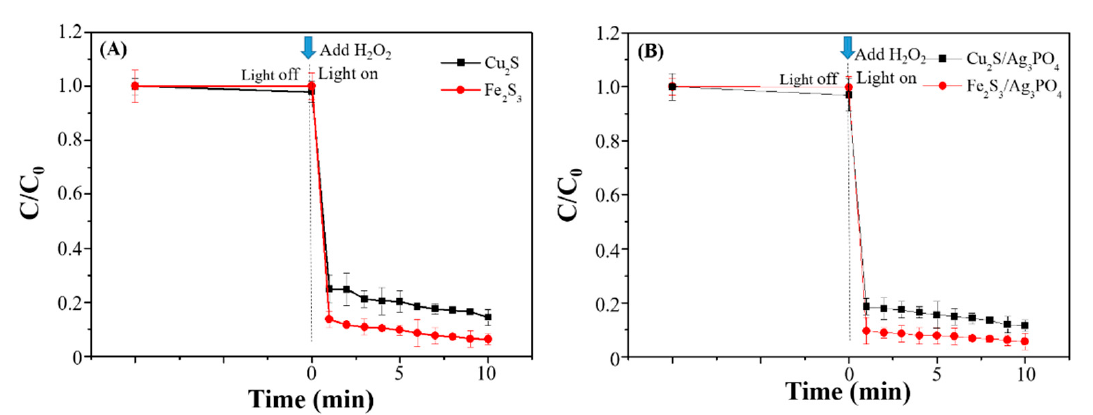
Figure 10. Photo-Fenton reaction for RhB degradation by different samples: ( A ) Cu 2 S (black) and Fe 2 S 3 (red); and ( B ) Cu 2 S/Ag 3 PO 4 (black) and Fe 2 S 3 /Ag 3 PO 4 (red) composites.